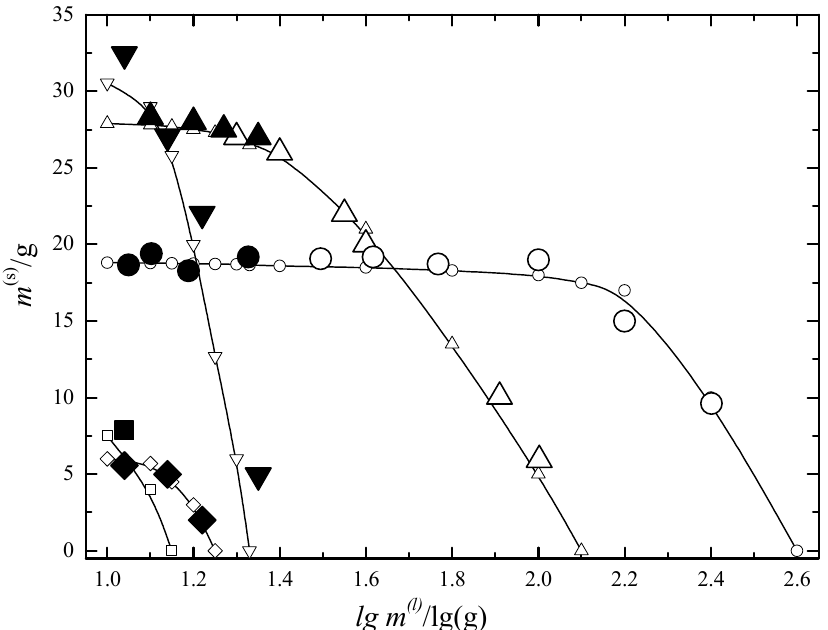
Figure 5. Open crystallization curves in the Na + , K + , Ca 2+ , Mg 2+ // Cl − , SO 42 − - H 2 O system during water evaporation at 298 K. Dependence between the solid phase masses ( m ( s ) ) and solution mass ( m ( l ) ). Open points, calculation; solid points, experimental data; CaSO 4 ·2H 2 O, ○ , ● , m (s) ·10; NaCl, △ , ▲ ; MgSO 4 ·7H 2 O+MgSO 4 ·6H 2 O, ▽ , ▼ , m (s) ·10; KCl, ◇ , ◆ , m (s) ·10; KCl·MgCl 2 ·6H 2 O, □ , ■ , m (s) ·10. Initial composition of solution (mol·kg − 1 ): m(Na + ) = 0.485, m(K + ) = 0.010, m(Ca 2+ ) = 0.011, m(Mg 2+ ) = 0.056, m(Cl − ) = 0.565, m(SO 42 − ) = 0.029, initial solution mass M (l)0 = 1000 g.